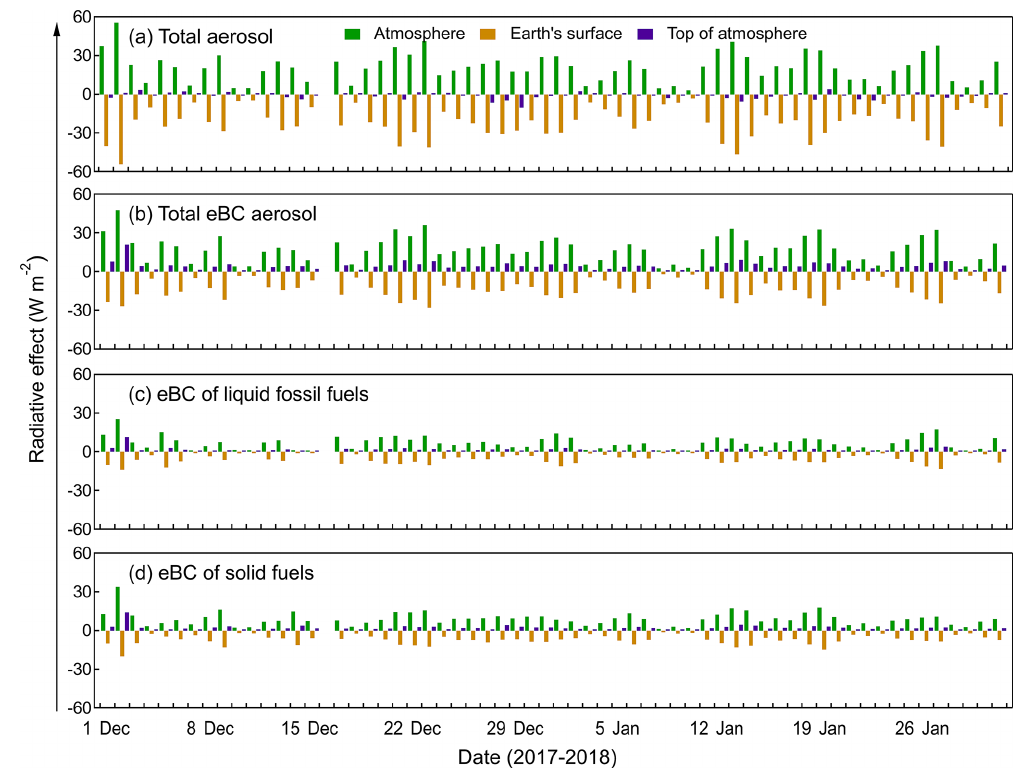
Figure 11. Time series of hourly averaged direct radiative effect caused by (a) total aerosol and (b) equivalent black carbon (eBC), as well as eBC of (c) liquid fossil fuels and (d) solid fuels at the Earth’s surface, the top of the atmosphere, and in the